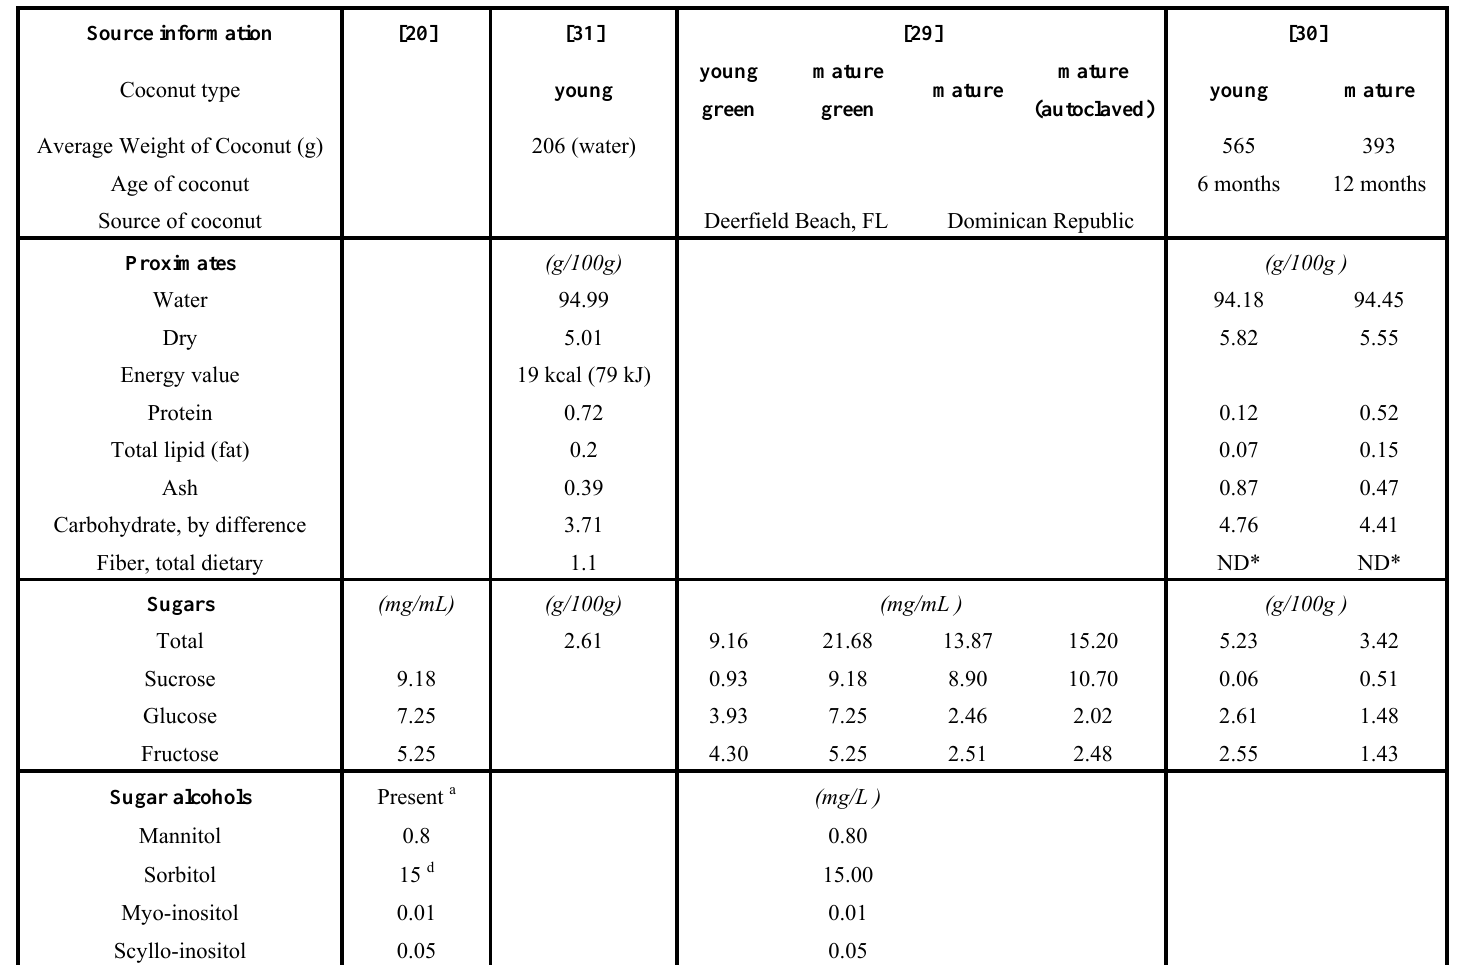
Table 1. Chemical composition of coconut water